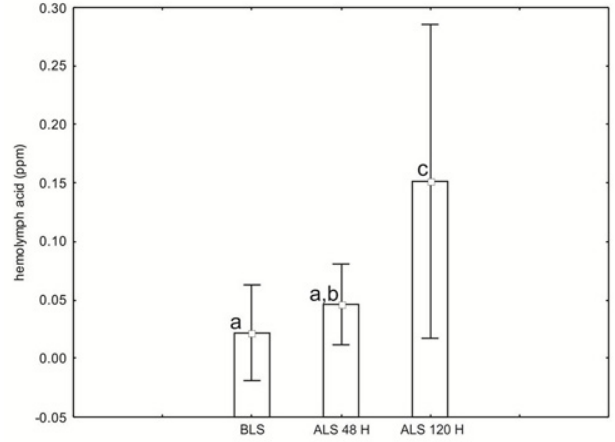
Fig 2 . Mean concentration (ppm) and standard deviation of fatty acid content in the hemolymph in groups of workers before lipid supplementation (BLS) and after lipid supplementation (ALS 48 h and ALS 120 h). Bars marked with the same letter show no statistically significant difference (p > 0.05); bars marked with different letters show statistically significant differences (p <